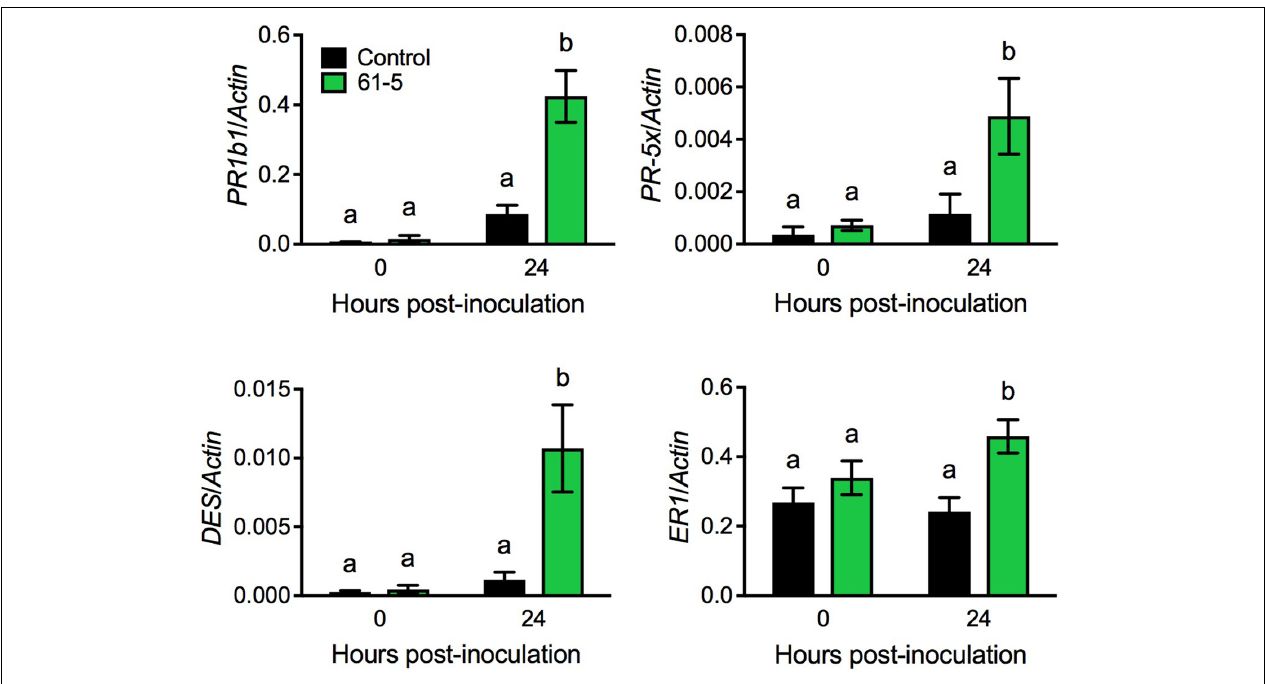
FIGURE 4 | Pst J4-induced expression of PR1b1 , PR-5x , DES , and ER1 in the transgenic line 61-5. Plants were spray inoculated with the bacterial pathogen Pst J4 (10 8 cfu/mL). Leaf tissues were collected at the indicated time points. Total RNA was extracted from the inoculated leaves and analyzed for the expression of the indicated genes using qPCR. Expression was normalized against the constitutively expressed Actin gene. Data represent the mean of three biological replicates with SD. Different letters above the bars indicate significant differences (Tukey’s test, P <